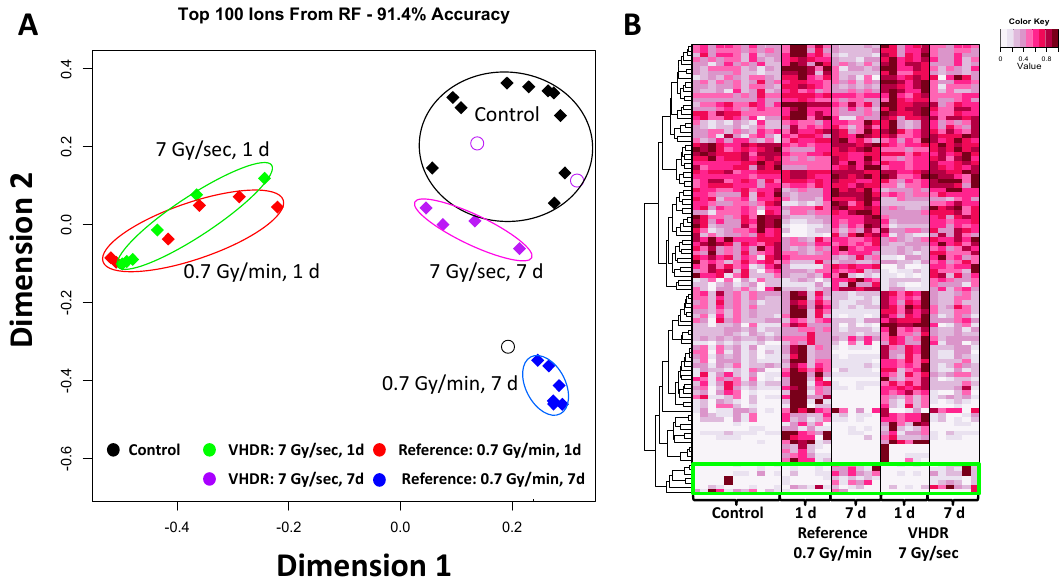
Figure 1. Results from the Random Forests analysis in urine. ( A ) A multidimensional scaling (MDS) plot of the top ranked 100 ions in ESI+ (classification accuracy 91.4%). The highest perturbation for both dose rates occurred at 1 day (d). Mice exposed to very high-dose rate (VHDR) ionizing radiation (IR) (7 Gy/sec) returned closer to control levels at 7 d compared to mice exposed to the reference dose rate (0.7 Gy/min). ( B ) A heatmap of the top ranked 100 ions in ESI+ showed that the divergence of the 1 d samples includes both metabolites occurred at higher and lower concentration compared to the control in urine. Each metabolite is scaled by the maximum intensity value of that metabolite in the data set. While most metabolite levels returned to control levels at 7 d, a small subset showed increased levels (green box).